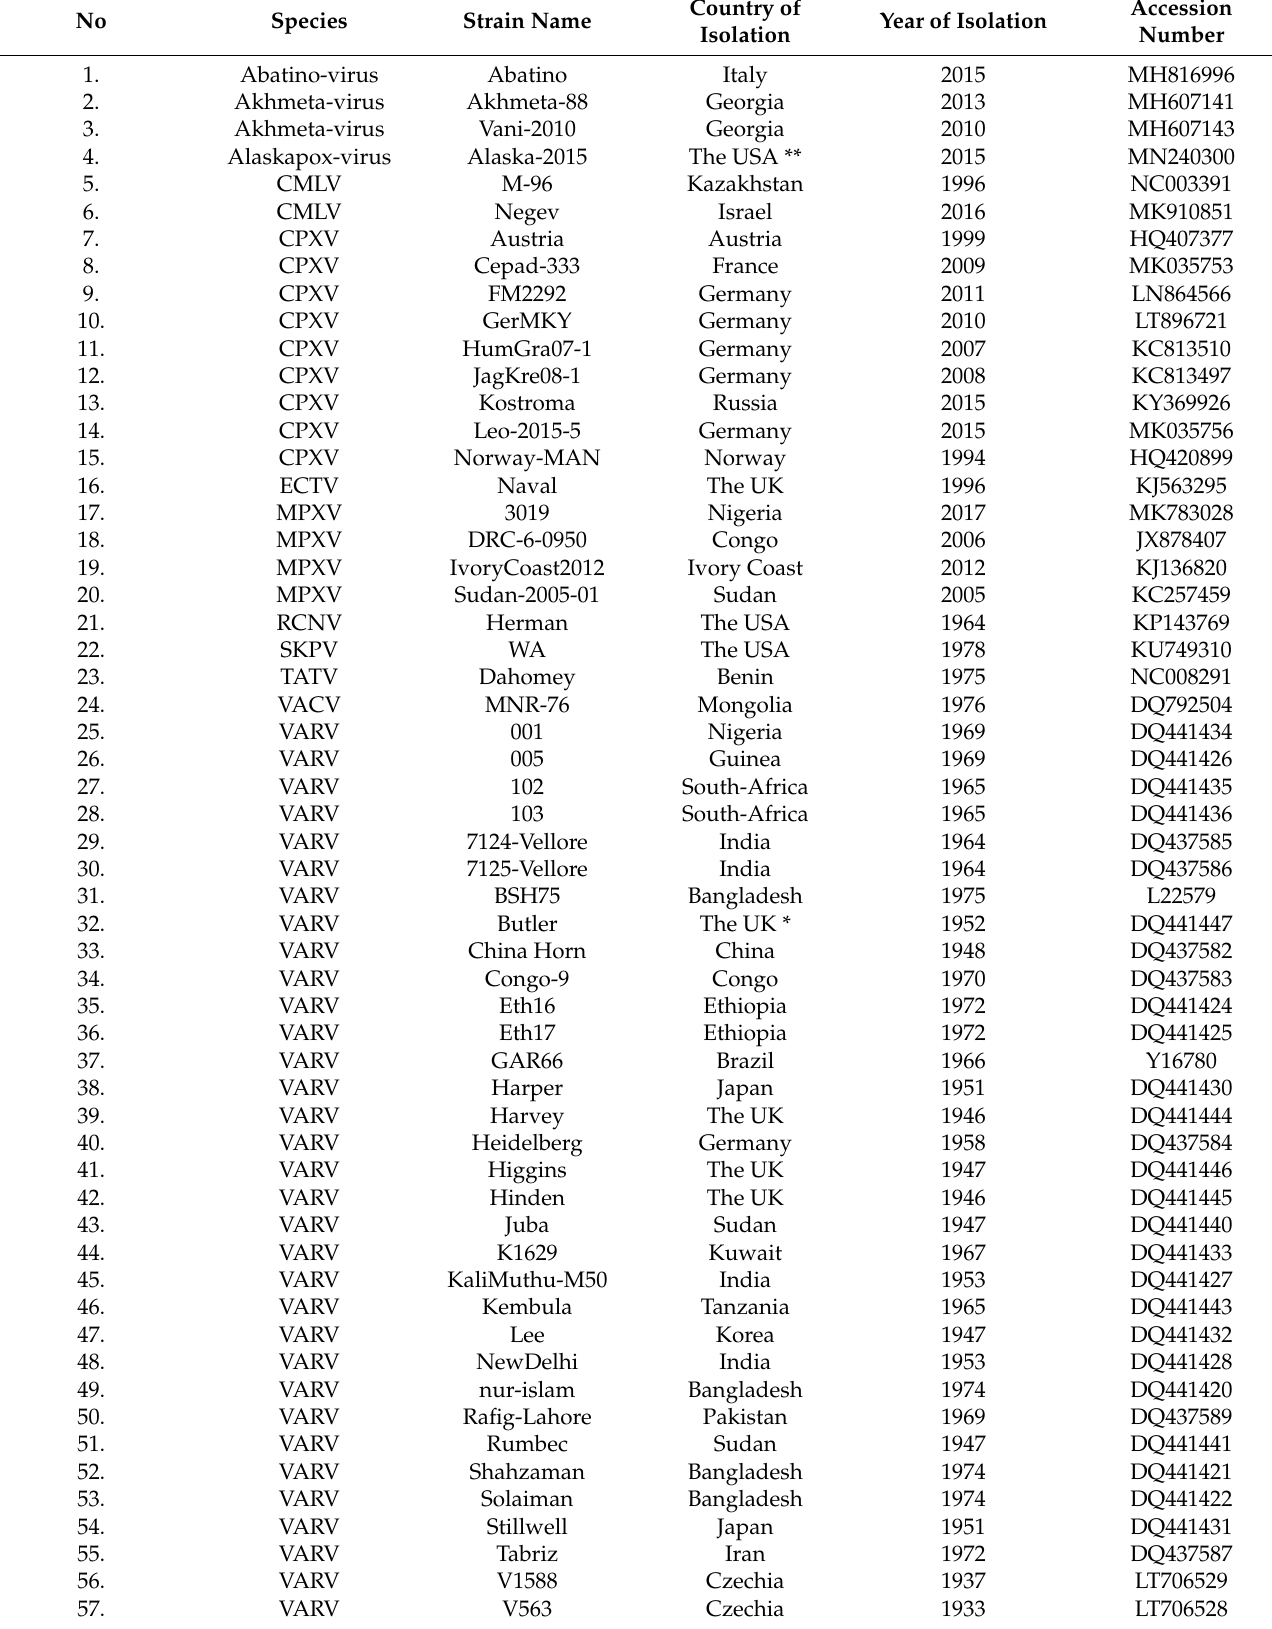
Table 1. Genome sequences of the orthopoxviruses included in the